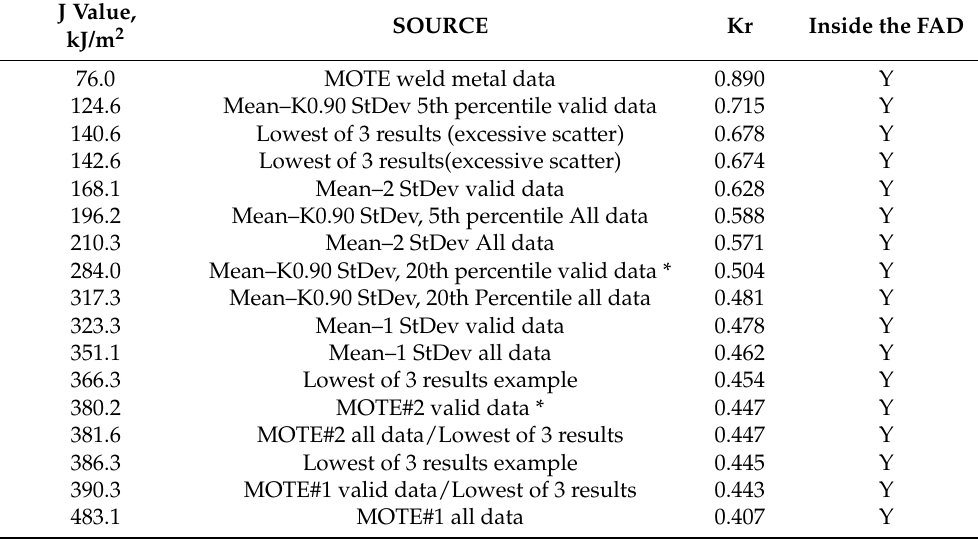
Table 8. Summary of ECA sensitivity